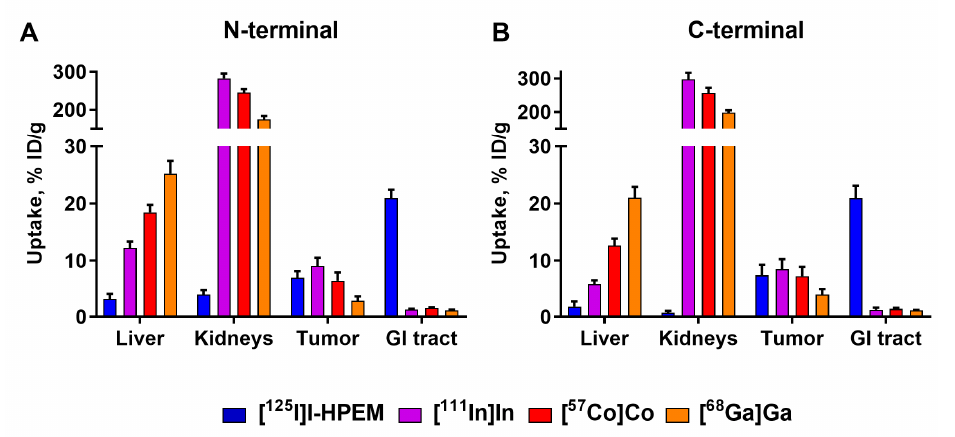
Figure 3. Influence of position (( A ) N-terminal or ( B ) C -terminal) and composition ([ 125 I]I-HPEM, [ 111 In]In, [ 68 Ga]Ga, [ 57 Co]Co) of the label on biodistribution of DARPin Ec1 variants 3 h post injection (p.i.) in Balb/c nu/nu mice bearing DU145 prostate cancer xenografts. Uptake is presented as % ID/g (average from four mice ± SD; from seven mice ± SD for the [ 57 Co]Co C -terminal group). Uptake in gastrointestinal (GI) tract with content is presented as % ID per whole sample. Table 7. Tumor-to-normal-tissue ratios for DARPin Ec1 variants labeled with [ 57 Co]Co, [ 68 Ga]Ga, [ 111 In]In and [ 125 I]I-HPEM at N - or C -terminus 3 h p.i. in Balb/c nu/nu mice bearing EpCAM-expressing DU145 xenografts (average from 4 mice ± SD; from 7 mice ± SD for the [ 57 Co]Co C group). One-way ANOVA with Bonferroni’s multiple comparisons test was performed to find significant differences between Ec1 variants with the same label position ( N - or C -terminus).